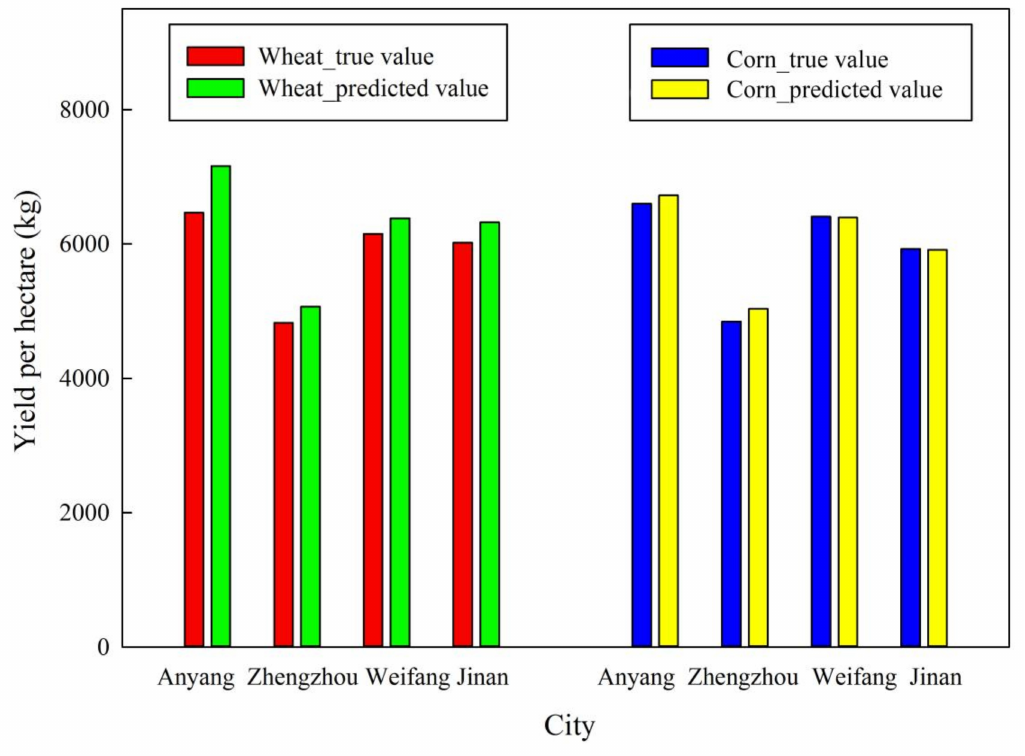
Figure 6. The comparison of predicted value and true value of test set in the